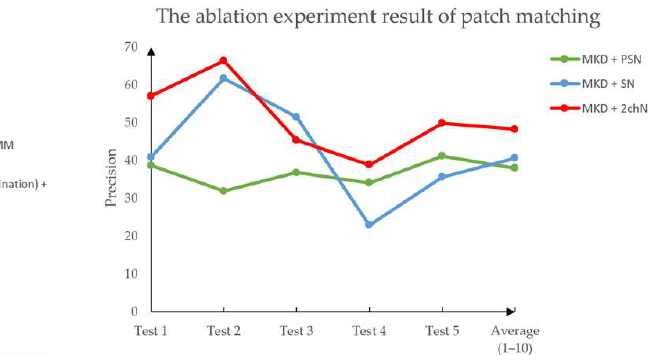
Table 5. Ablation experiment result of patch matching.